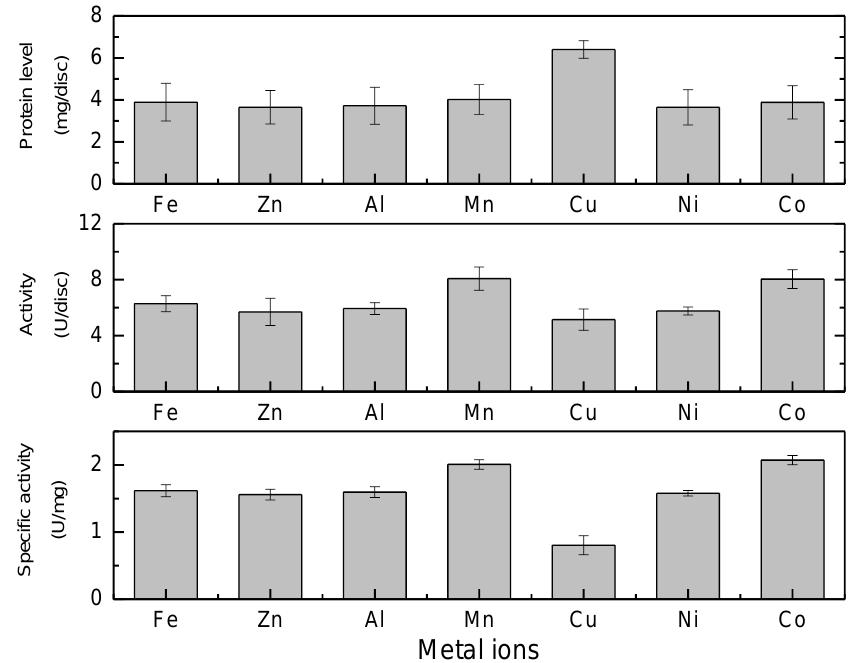
Figure 4. Protein adsorption capacity, activity, and specific activity of IMAMs chelated with different metal ions on CelA.